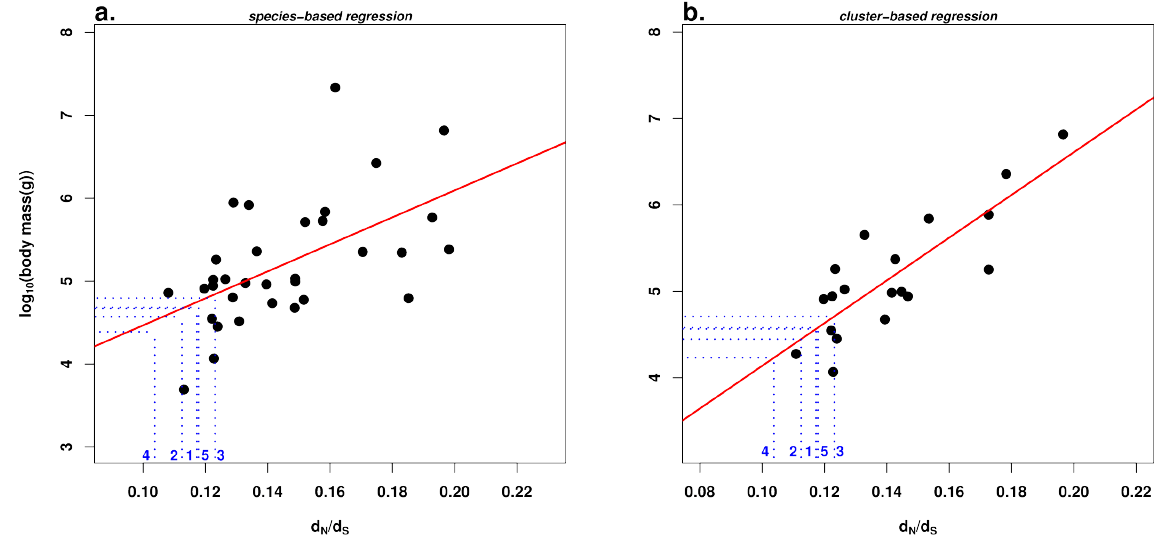
Figure 2 – Relationship between log 10 (body mass) and d N / d S in Cetartiodactyla. a. Each dot represents a species. d N / d S values were obtained using substitution mapping. The regression line of log10(body mass) on terminal branch dN / d S is shown in red. The blue dashed lines show ancestral body mass predictions for five basal branches of Cetartio- dactyla. Branch labels: see figure 1. b. Each dot represents a cluster of monophyletic species. Body mass value of a cluster corresponds to the mean of the log10-transformed values of its